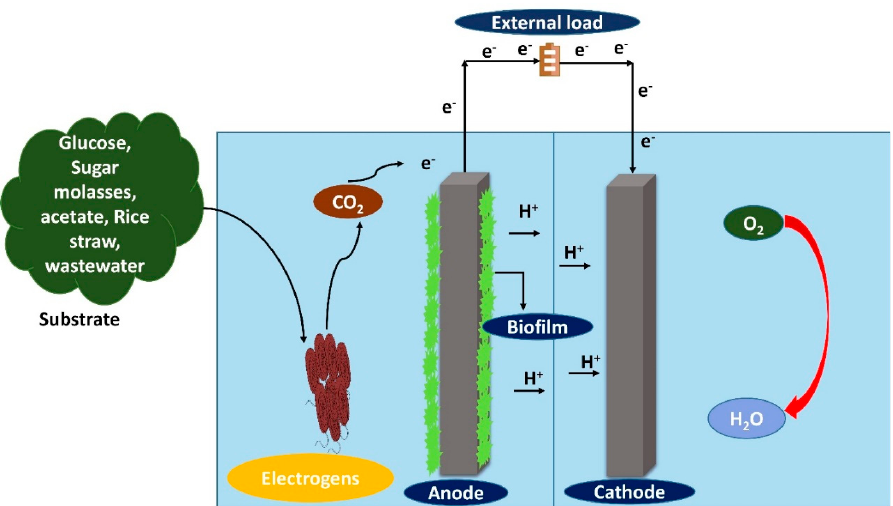
Figure 4. Representation of power generation by using organic contents as substrates by electrogens in a benthic microbial fuel cell.